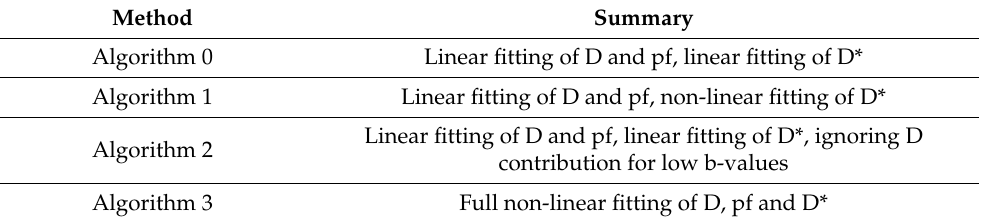
Table 1. Overview of the four prototype algorithms used in MR Body Diffusion Toolbox software to analyze the ROIs data. D: pure diffusion coefficient; D*: pseudodiffusion coefficient; pf: perfusion fraction.